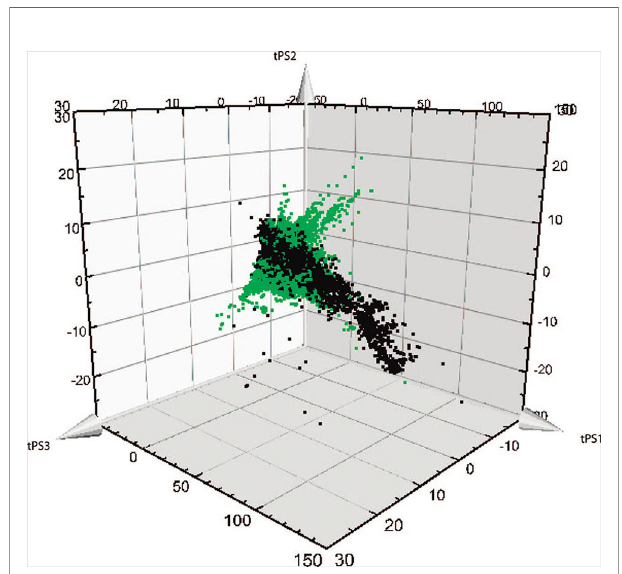
FIGURE 1 | Representation of the divergent diversity between natural and synthetic compounds. (adapted with permission from Rosén et al. (2009a). Copyright 2009 American Chemical Society). Biologically relevant chemical space covered by natural products (in green) or by bioactive medicinal chemistry compounds from the database WOMBAT (in black) in the fi rst three principal